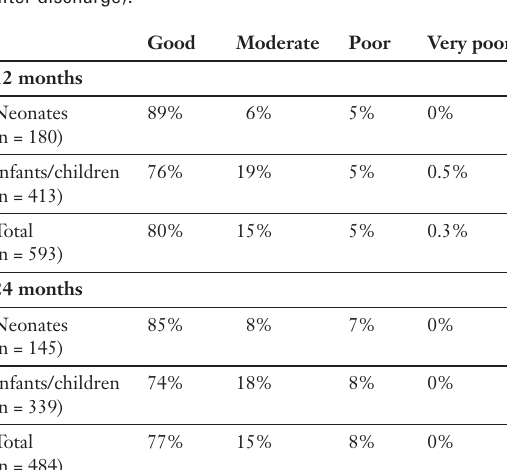
Figure 1 Patient flow over the 24 months follow-up